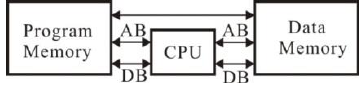
Figure 7. Cloud detection hardware system